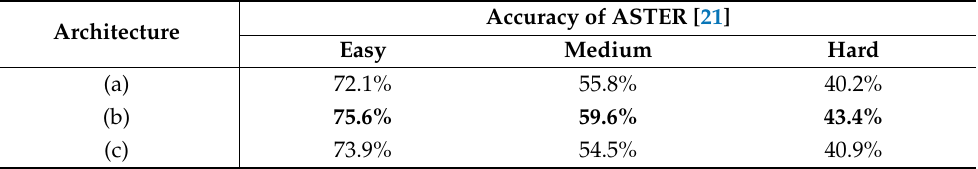
Table A1. Comparison results of the three SR Block